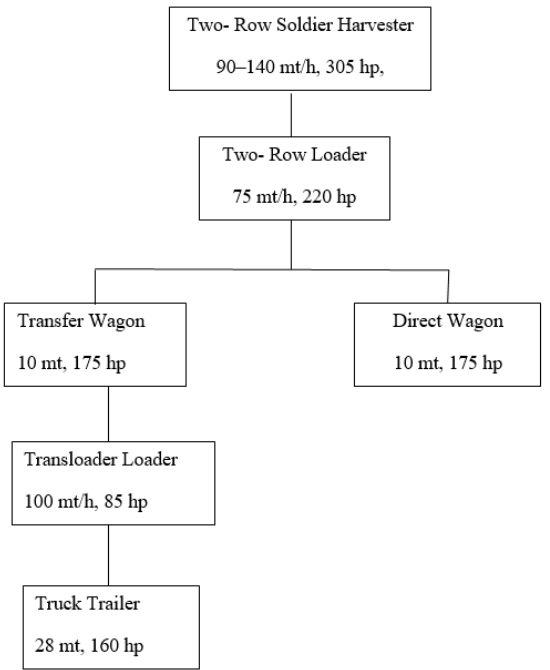
Figure 1. Energy cane harvesting and hauling unit (adopted from sugarcane harvesting system, 36).